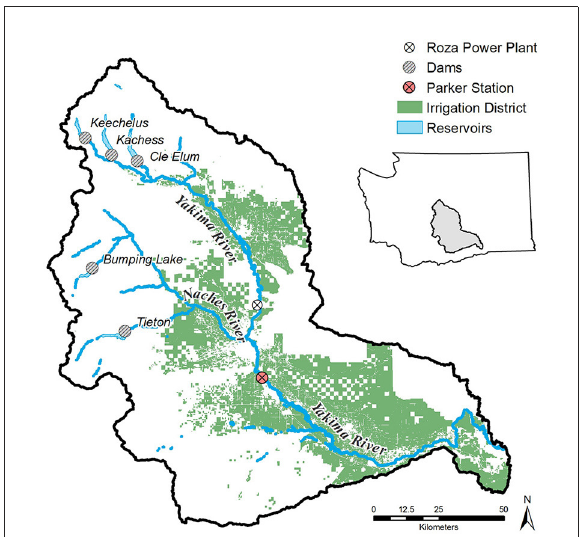
FIGURE1 Location of reservoirs, irrigation districts, the Roza hydropower plant, and control point (Parker station) in the Yakima River Basin (Zhao et al.,